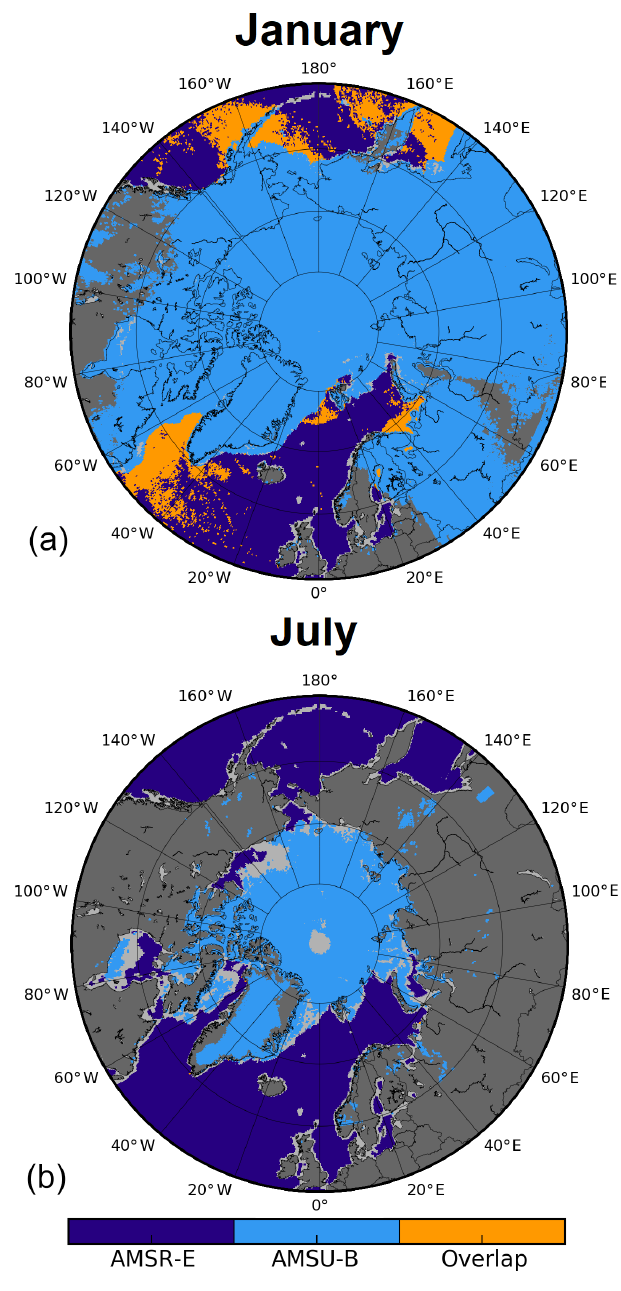
Figure 12. Coverage and overlap area of the merged AMSU-B and AMSR-E retrieval for (a) winter (6 January 2008) and (b) summer (6 July, 2008). Note that there is no overlap between retrievals (or- ange) for the summer case